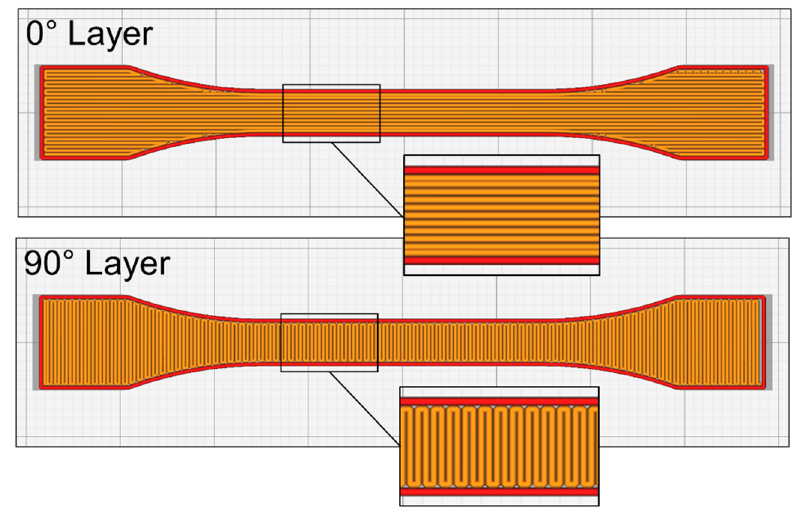
Figure 2. Infill pattern of successive layers within a given tensile specimen.